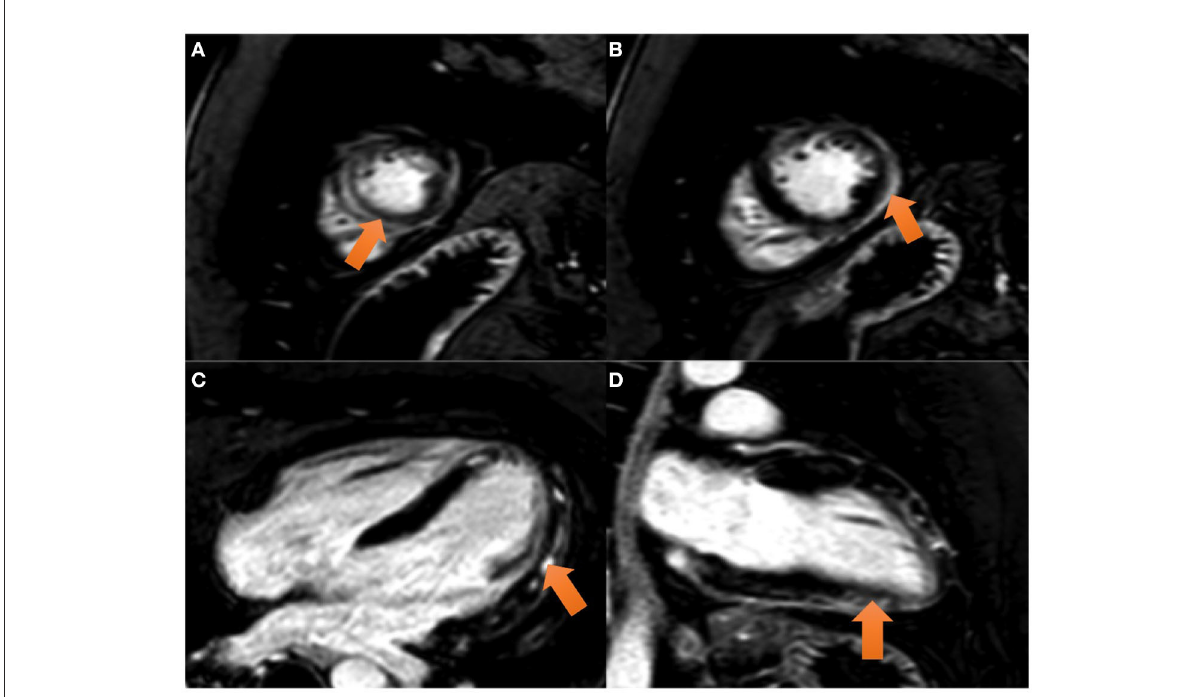
FIGURE3 CMR images: (A) T2 STIR sequence: a high ratio ( > 2) is seen in the intensity between the myocardium and the skeletal muscle compatible with a generalized edema. (B) Color-coded image of T2 mapping in LV mid-chamber. The arrow marks an increased T2 value (T2 = 60ms) in the lateral and inferolateral wall. (C, D) T1 mapping and T1 enhanced mapping, respectively. In T1 mapping, extensive area of increased T1 value (view pink and orange areas) in lateral and inferolateral walls. On quantitative analysis, values on the native T1 map were 1,160ms (normal value 1,025–1,075ms). In T1 enhanced mapping, these areas area correlated with increased extracellular volume